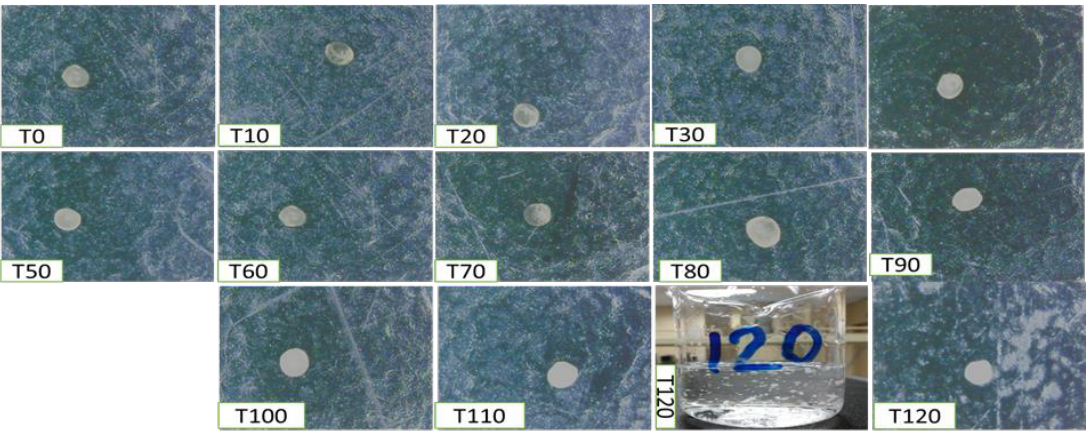
Figure 10. Swollen alginate-BSO bead characterization comprised of evidence on its thickness and graphic appearance in SGF media (pH 1.2) using a digital camera. Magnification at 50×.